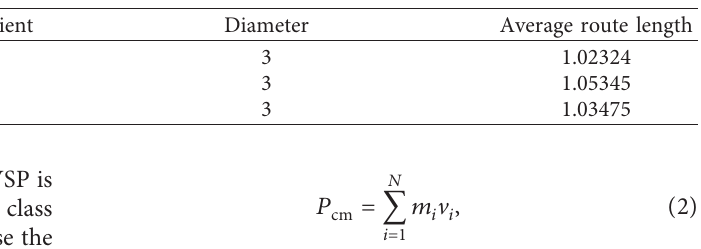
Table 5: Structural metrics for coupled